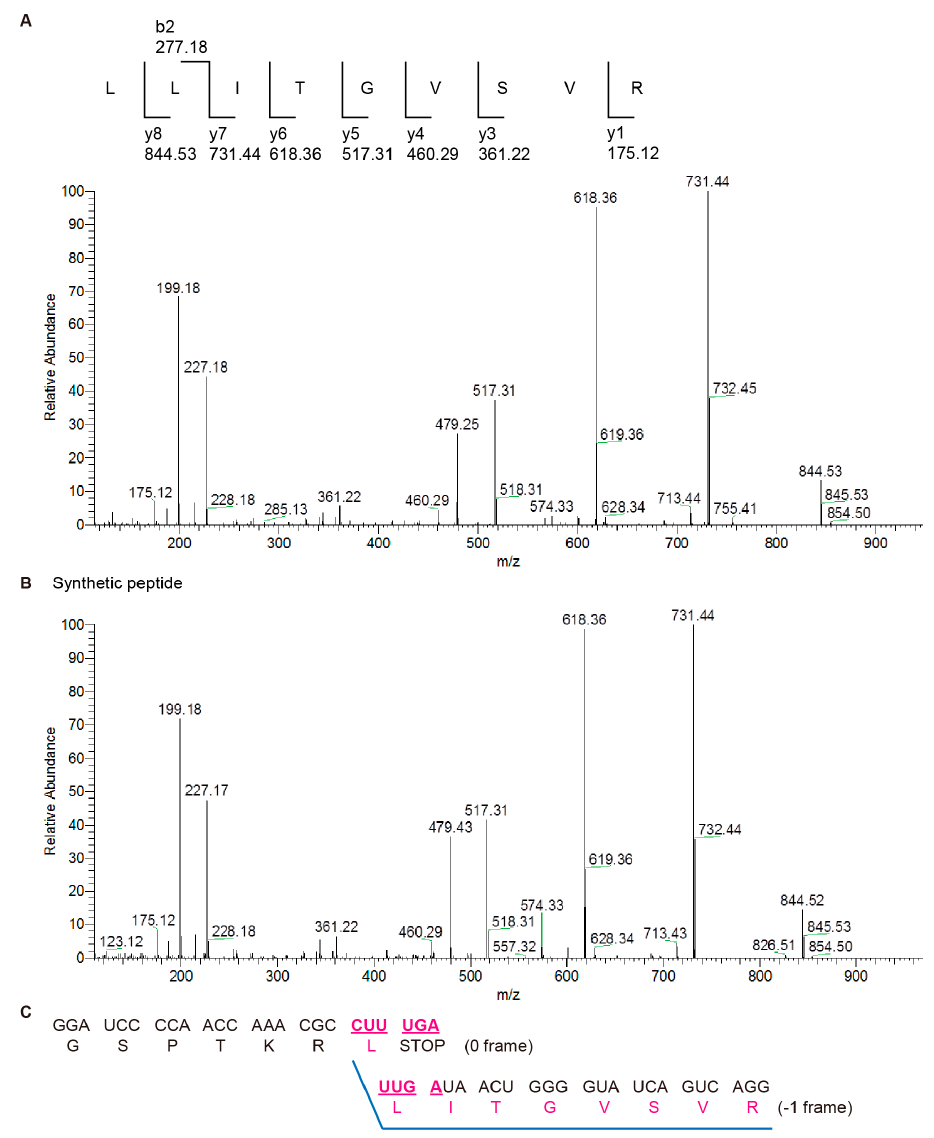
Figure 4. Non-canonical − 1 frameshifting confirmed by mass spectrometry analysis. ( A ) Fragmentation spectrum of the frameshifting site spanning peptide recovered from in-gel digestion sample. The fragment ions identified are indicated on top. ( B ) Fragmentation spectrum of chemically synthesized frameshifting site spanning peptide standard. ( C ) Nucleotide sequences spanning the 0 frame/ − 1 frame junction and corresponding amino acids encoded in the two different frames with the characterized LLITGVSVR peptide sequences underlined in blue color.